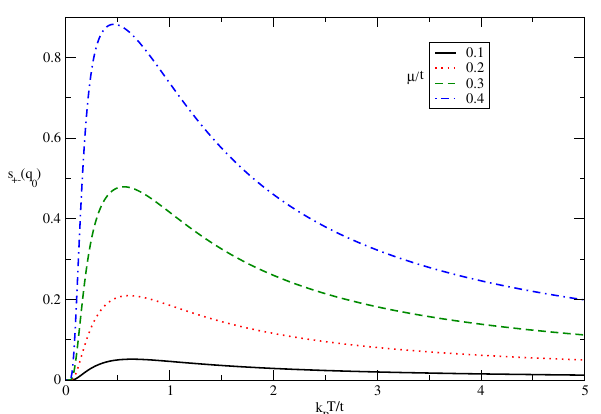
( q 0 , T ) of doped Germanene layer versus normalized +−